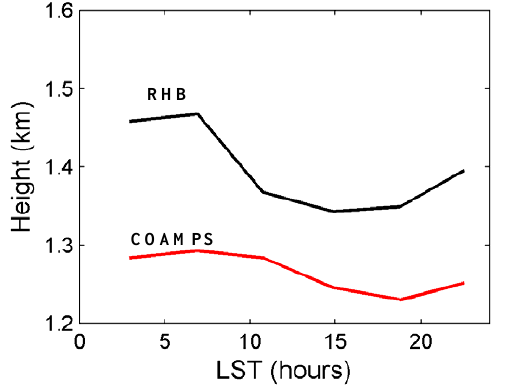
Fig. 13. Diurnal variations of mean MBL heights computed from the RHB soundings (black) and the COAMPS forecasts (red).